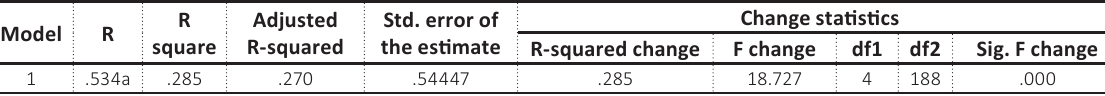
Table 7. Model summary